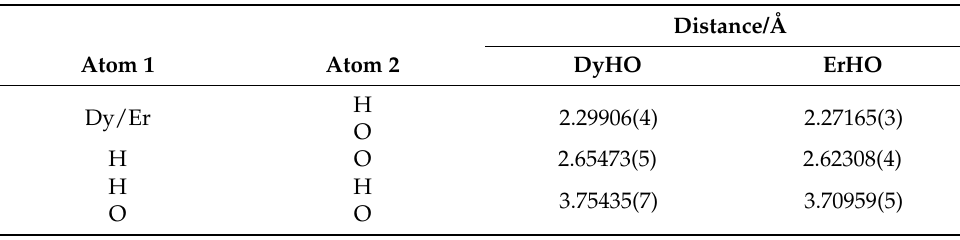
Figure 3. Rietveld refinement of the crystal structures of ErHO based on neutron diffraction data at ambient temperature ( λ = 1.155 Å) and contributions of the included crystal structures (bottom). R wp = 2.50%, GoF = 1.6. Phase information: ErHO F 43 m (81.2(3) wt%, R tion calc , blue curve: difference meas-calc , purple curve: background. Table 2. The interatomic distances in DyHO and ErHO based on neutron diffraction data at ambient